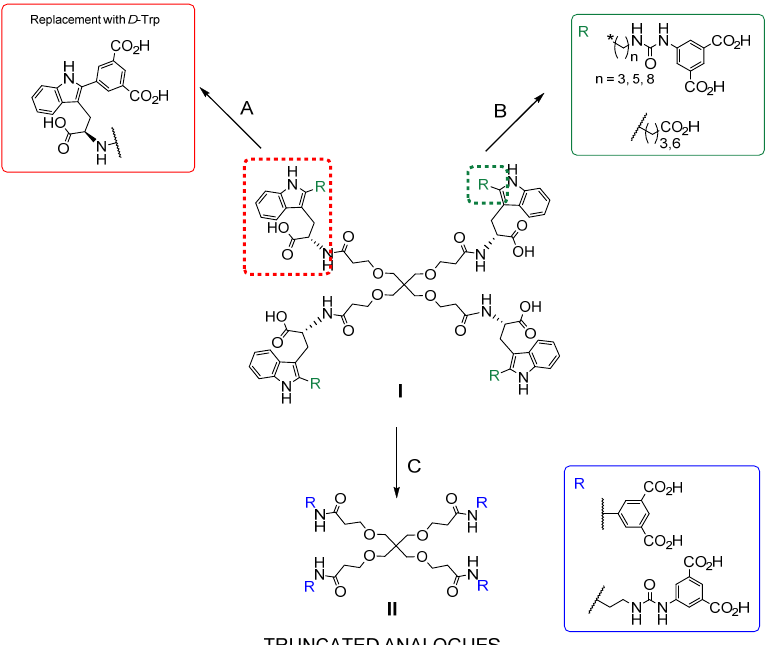
Figure 2. Structural modifications explored in this work. A. D -Trp instead of L -Trp. B. Alkyl urea linkers of different length between the isophthalic acid moiety and the C2 position of Trp. C. Trp- less analogues.